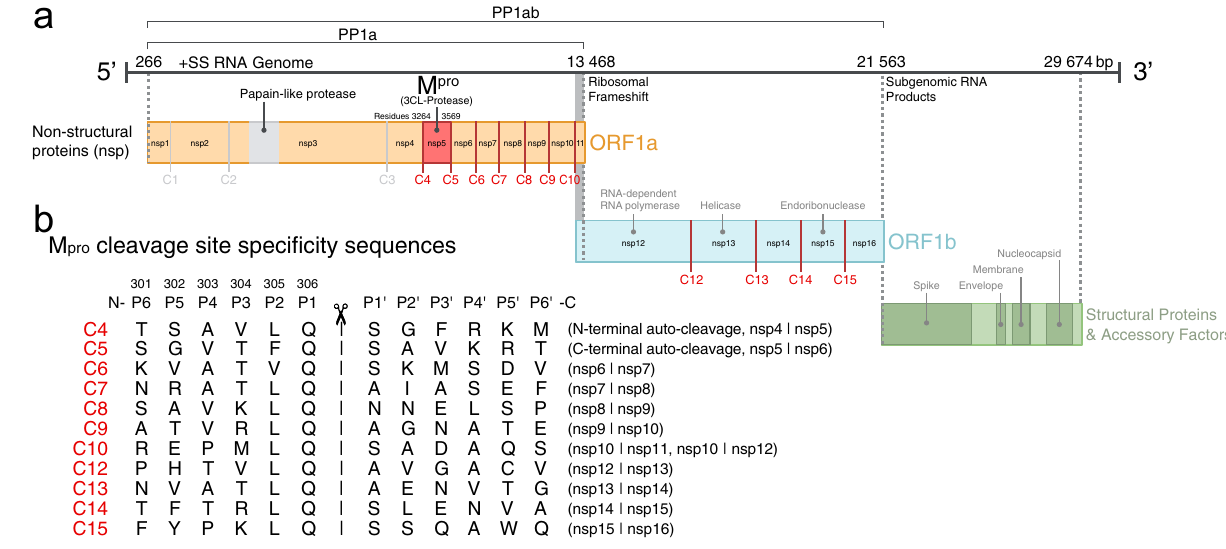
Fig. 1 | M pro cleavage sites in SARS-CoV-2 polyprotein processing. a Schematic overviewoftheSARS-CoV-2genome.Openreadingframes(ORF)1aand1bencode polyproteins pp1a and pp1ab that together contain a total of 11 M pro cleavage sites (C4-10, C12-C15, red). b Sequence alignment of the SARS-CoV-2 M pro cleavage-site